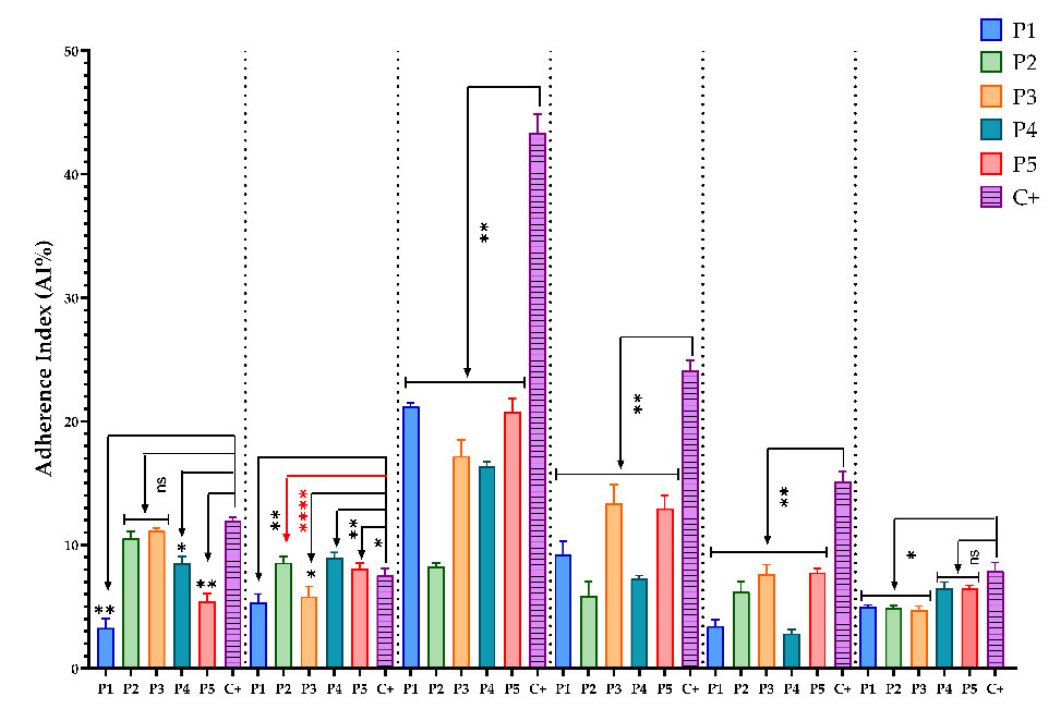
Figure 3. Graphic representation of AI% values representing the influence of BPE on the adherence capacity of yeast strains; (P1–P5)-BPE samples; (C+)-yeast adherence control. The antimicrobial effect of BPE on yeast strains was compared using one-way ANOVA and Dunnett’s multiple comparisons tests. The results were considered statistically significant. (ns—not significant, p > 0.05; * p < 0.05; ** p < 0.01; **** p < 0.0001).